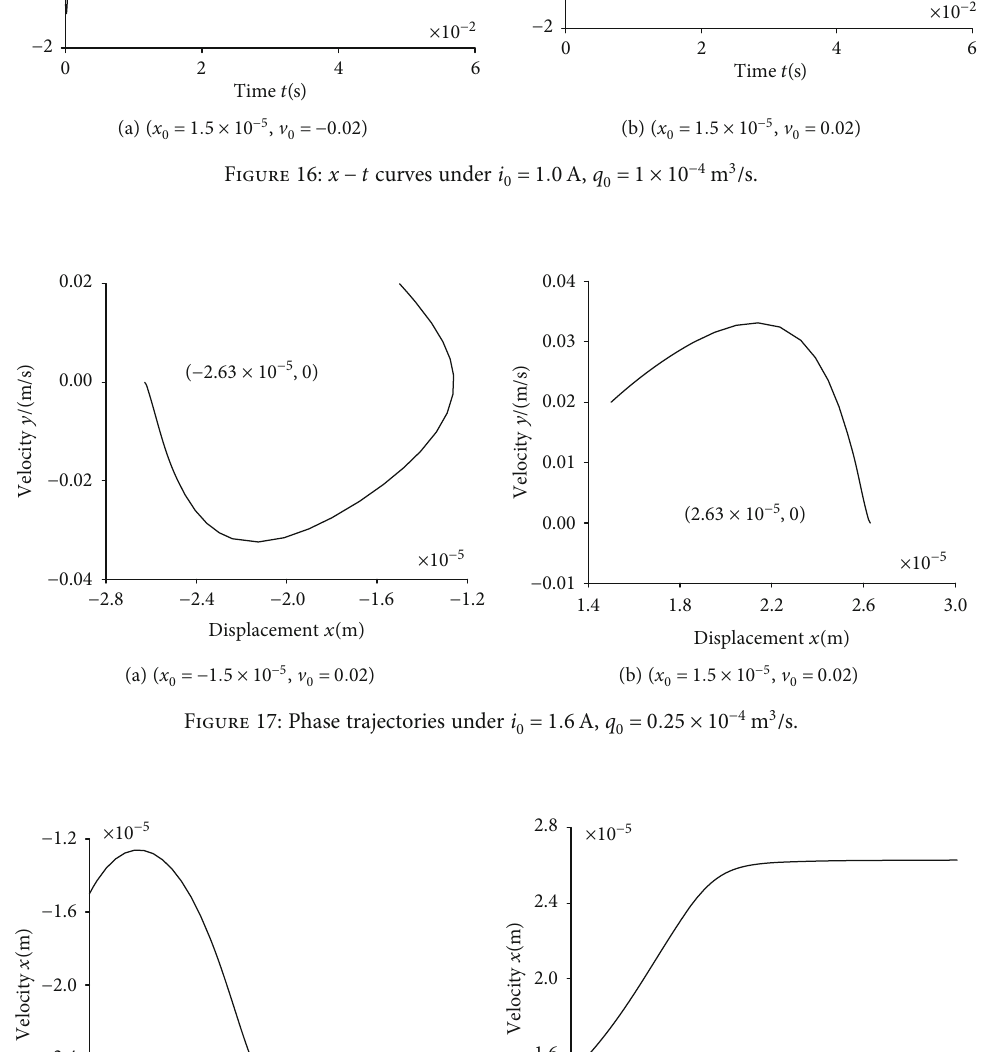
Figure 16: x − t curves under i